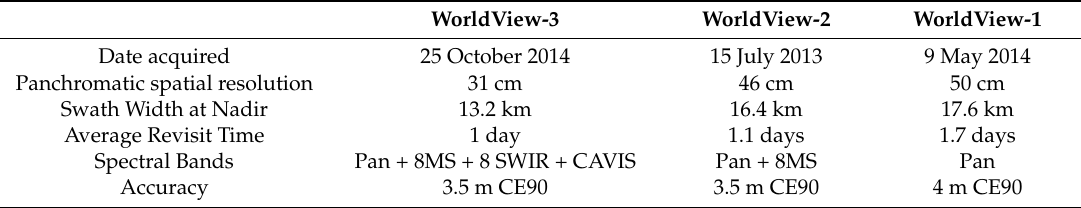
Table 1. Synoptic characteristics of WorldView imagery used in this